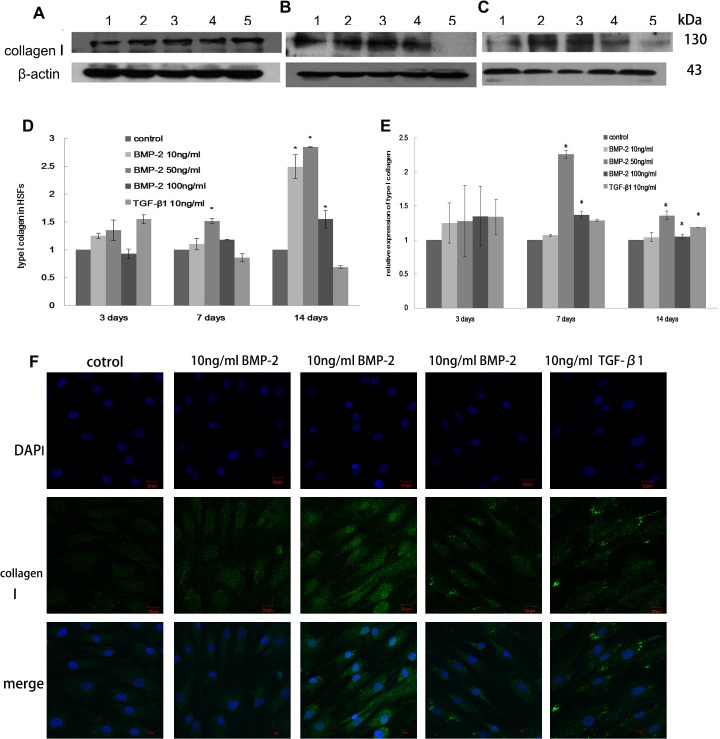
The effect of BMP-2 on type I collagen expression in HSFs.The synthesis of type I collagen in HSFs after 3 days (A), 1 week (B) and 2 weeks (C) of culture. Lane 1-Untreated control, Lane 2–10 ng/ml BMP-2, Lane 3- 50ng/ml BMP-2, Lane 4–100 ng/ml BMP-2, Lane 5- 10ng/ml TGF-β1. The data are expressed as the mean±SEM, N = 3, * p≤0.05 vs. control (D). The mRNA level of type I collagen in HSFs is shown (E). The data are expressed as the mean±SEM, N = 3, * p≤0.05 vs. control. Immunocytochemistry (F) also shows a BMP-2 induced increase in collagen type I expression in HSFs after 7 days culture.